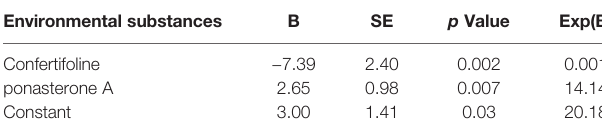
TABLE 4 | Multivariate forward stepwise logistic regression analysis the relationship between environmental substances and GD